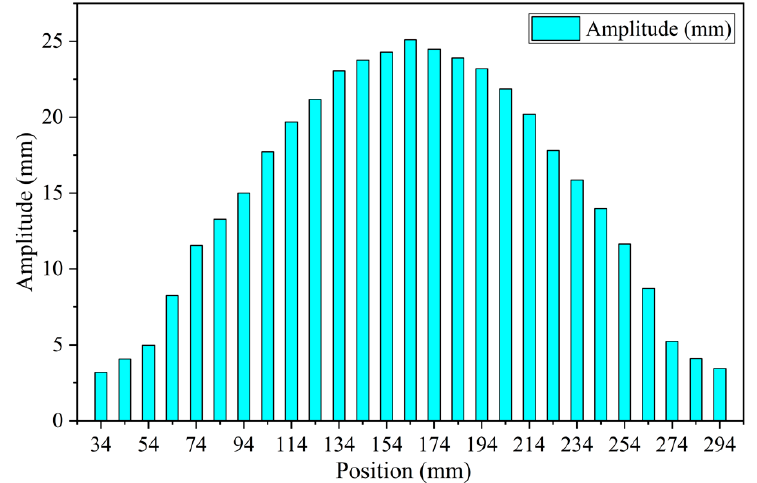
Figure 4. Vibration amplitude of each measuring point of the elastic sieve